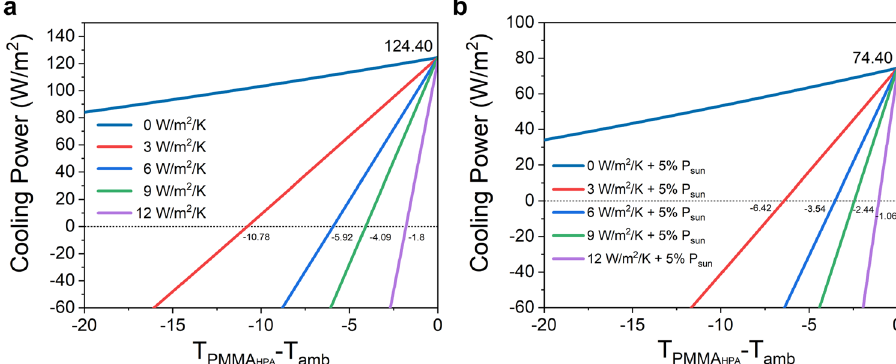
Fig. 8 Calculated net cooling power with software MATLAB based on the theoretical simulation. a Calculated net cooling power during the nighttime. b Calculated net cooling power during the daytime. The variable h c is a combined nonradiative heat coef fi cient. Values of 0, 3, 6, 9, and 12 for h c are used in the calculations. For daytime calculations, 5% solar power absorption is